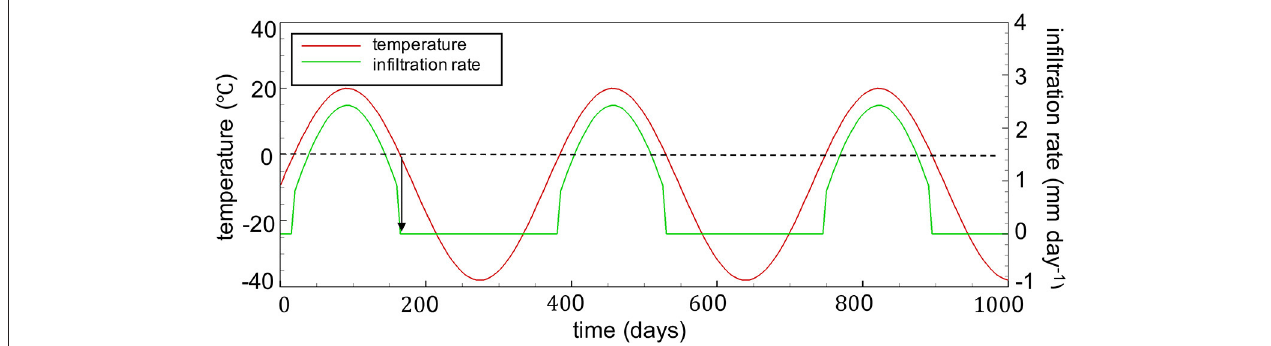
TABLE 2 | Parameters for sensitivity analyses of 1D and 2D simulations ( k refers to k ref FeS 1D simulations 2D